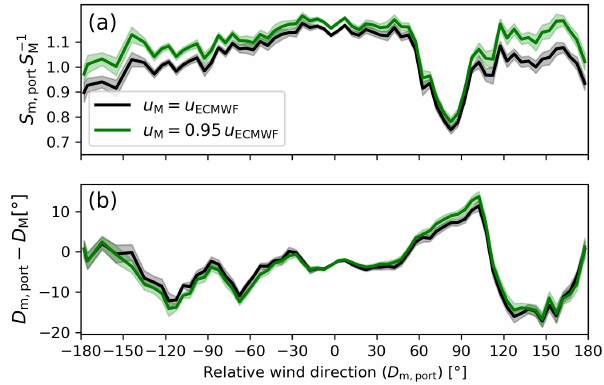
Figure B2. (a) Weighted average ratio between measured (port anemometer) and expected relative wind speed as a function of rel- ative wind direction. The black (green) curve shows the result when using the ERA-5 wind speeds (scaled with a factor 0 . 95) as a free- stream reference. The shaded areas denote the error of the mean. Panel (b) is the same as (a) but for the relative wind direction dif- ference.